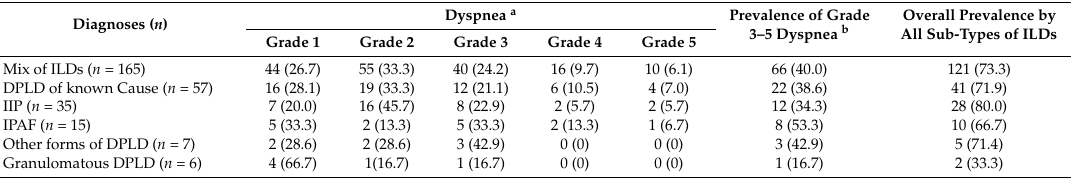
Table 2. Description * of dyspnea in patients with